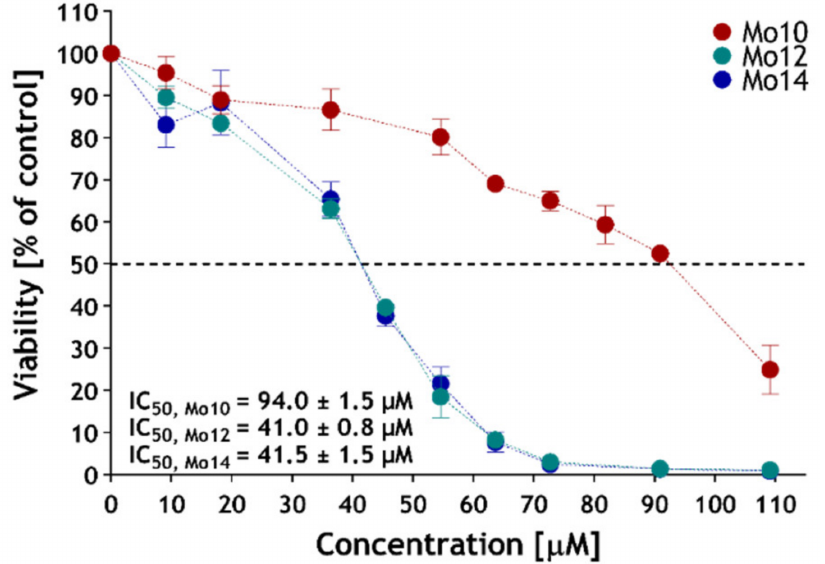
Figure 4. The viability of human keratinocyte cell lines (HaCaT) after 24 h incubation with selected permeation enhancers (Mo10, Mo12, Mo14). Data are presented as means ± SEM, n ≥